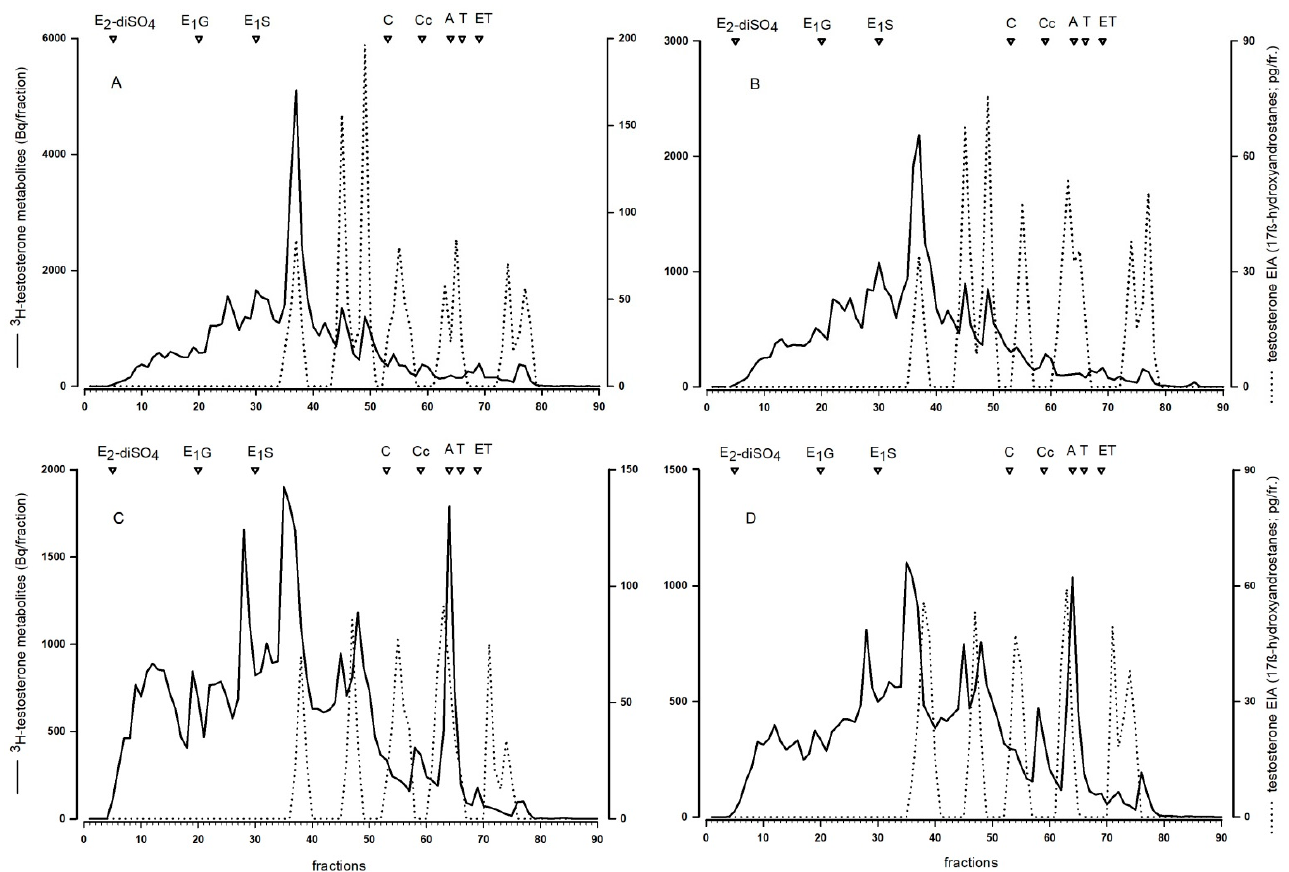
Figure 3. Reversed-phase HPLC separation of fecal 3 H-testosterone metabolites of male ( A , B ) and female ( C , D ) mice from the morning ( A , C ) and evening ( B , D ) injection group. Radioactivity (solid line) of each fraction was determined by liquid scintillation counting. Immunoreactivity (dashed line) was tested with the testosterone enzyme immunoassays. Open triangles mark the approximate elution positions of respective standards (E2-diSO4 = 17 β -estradiol-disulfate, E1-G = estrone-glucuronide, E1S = estrone-sulfate, C = cortisol, Cc = corticosterone, A = androstenedione, T = testosterone, ET = epitestosterone).